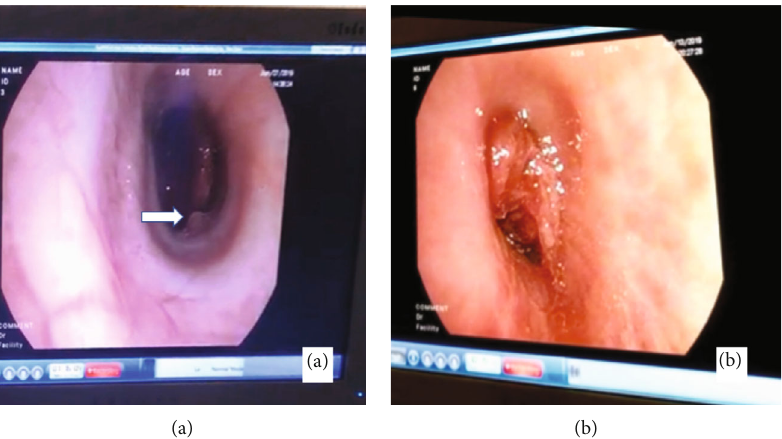
Figure 1: (a) Bronchoscopic fi ndings showing polyp-like lesion on the left main bronchus about 2 cm from the carina. (b) Blood clots proximal to the polyp-like lesion suggestive of active bleeding site.